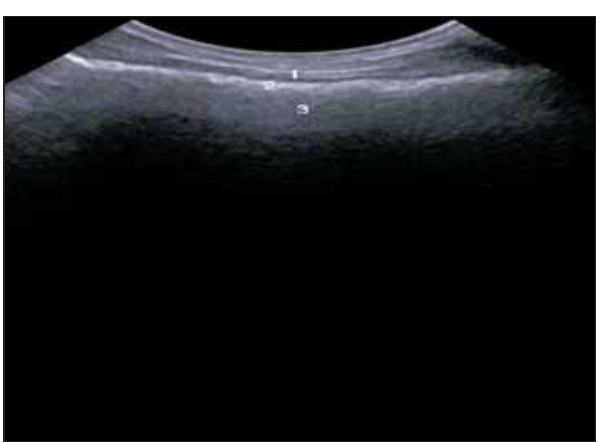
Figure-2: Ultrasonography of healthy goat's reticulum imaged at point just behind xiphoid cartilage shows